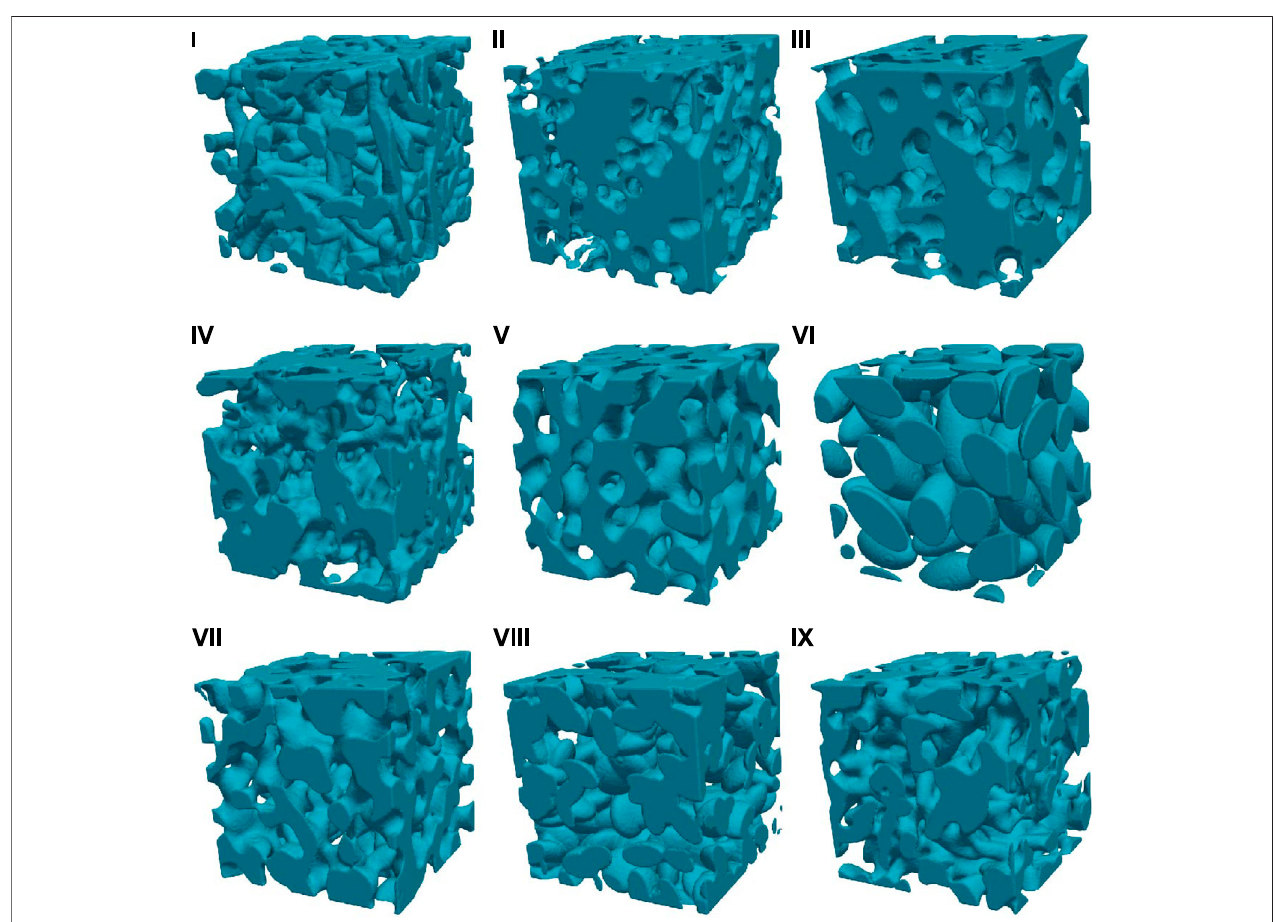
FIGURE1| Examples ofthedifferenttypes ofmicrostructures,showinganarti fi ciallygenerated fi ber system (I) ,channel system (II) ,spatialgraph (III) ,levelset ofa Gaussian random fi eld (IV) , level set of a spinodal decomposition (V) , as well as systems of hard ellipsoids (VI) , smoothed hard ellipsoids, (VII) , soft ellipsoids (VIII) , and smoothed soft ellipsoids (IX) . Note that the solid phase is always depicted in blue, whereas mass transport takes place in the transparent porous phase.